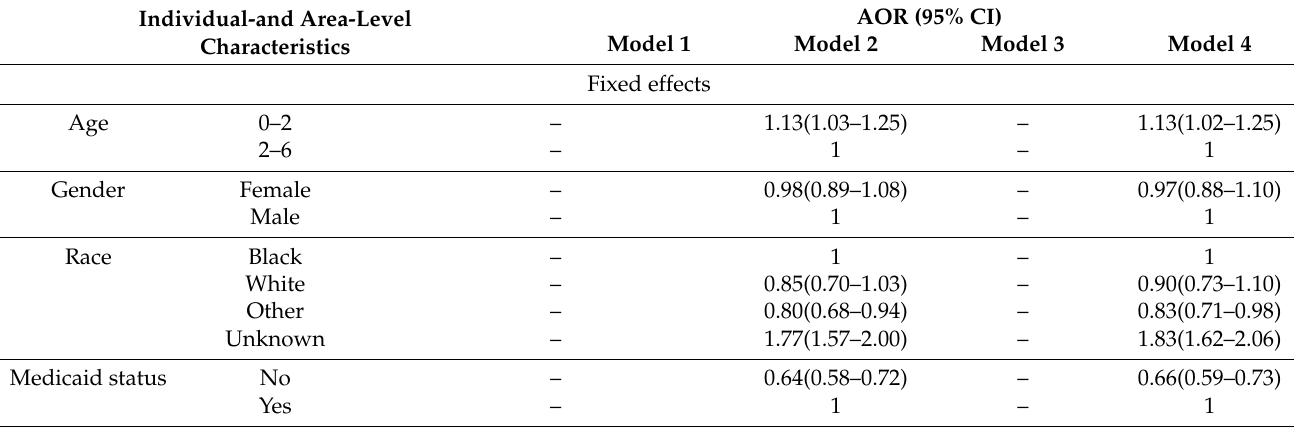
Table 4. Individual and area-level predictors of the likelihood of having a BLL 2 to <5 µ g/dL compared to BLL ≥ 5 µ g/dL, in 93,162 children aged 0–72 months living in 20 counties in or near the Atlanta Metropolitan Statistics area who had a valid venous blood lead test in the years